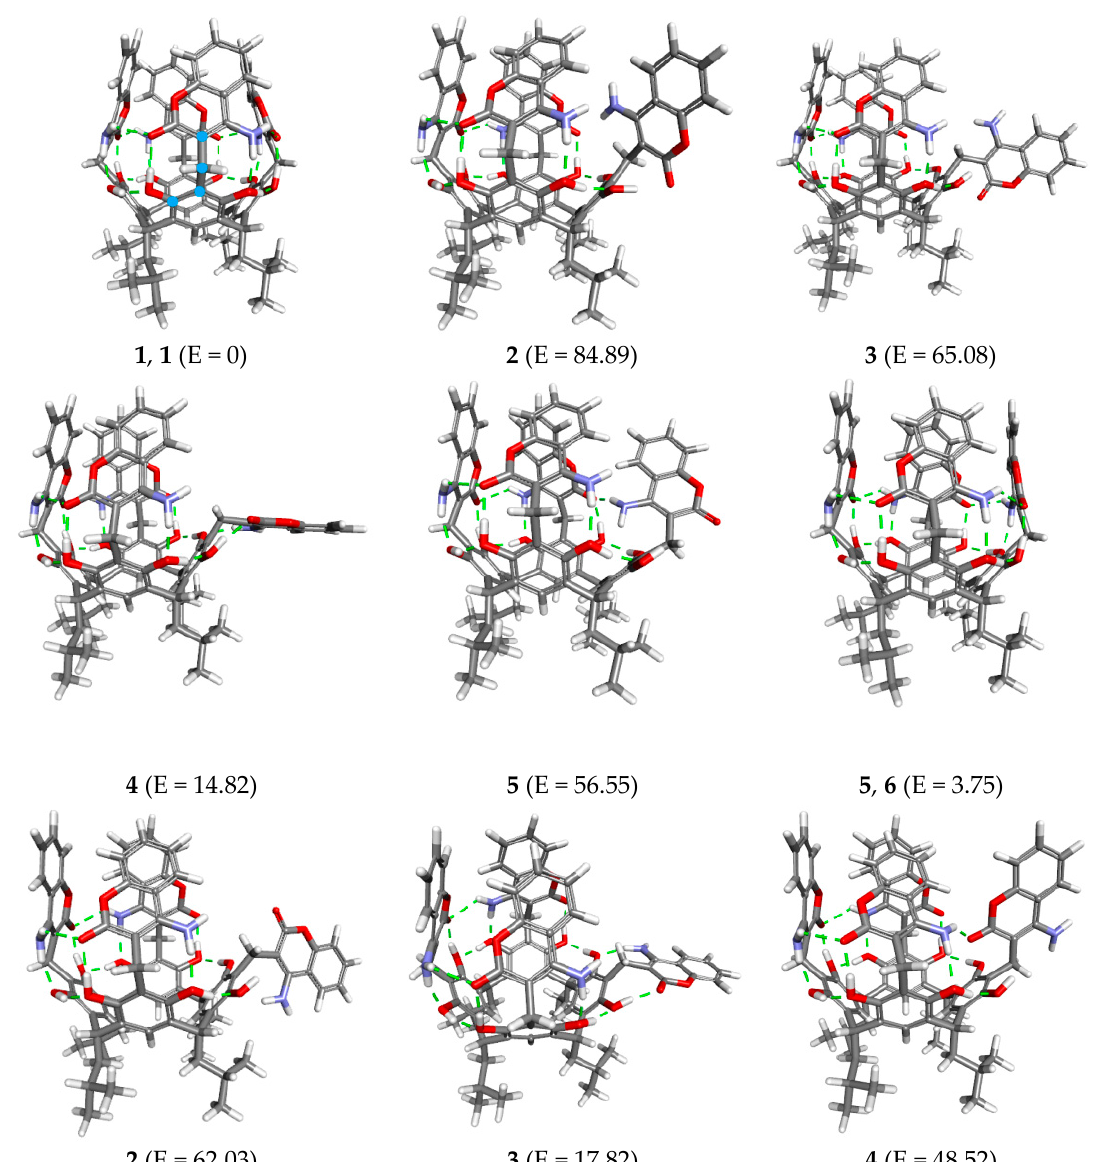
Figure 8. The structures of compound 3 with relative energies (kJ/mol) corresponding to the labelled points in Figure 7.